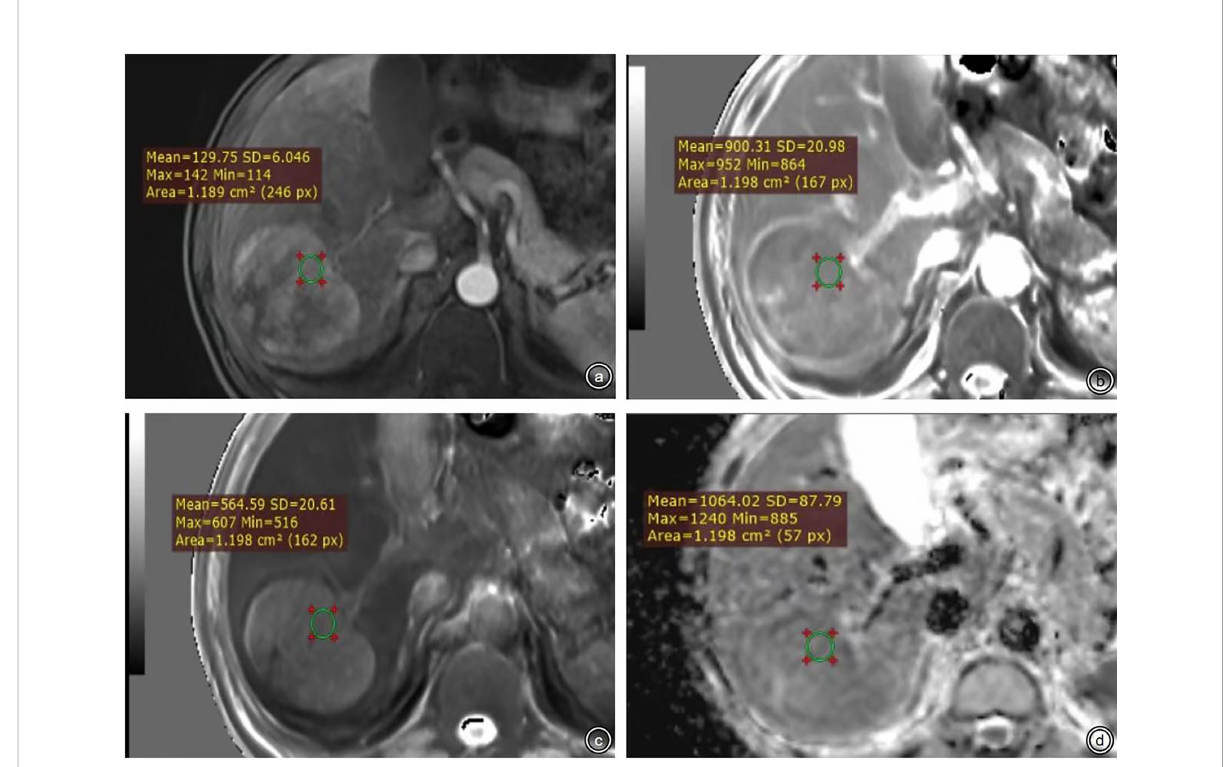
FIGURE 4 (A-D) were ROI measurement methods of T1 relaxation time obtained from pre-enhanced T1 mapping and 20 min after enhancement and the ADC